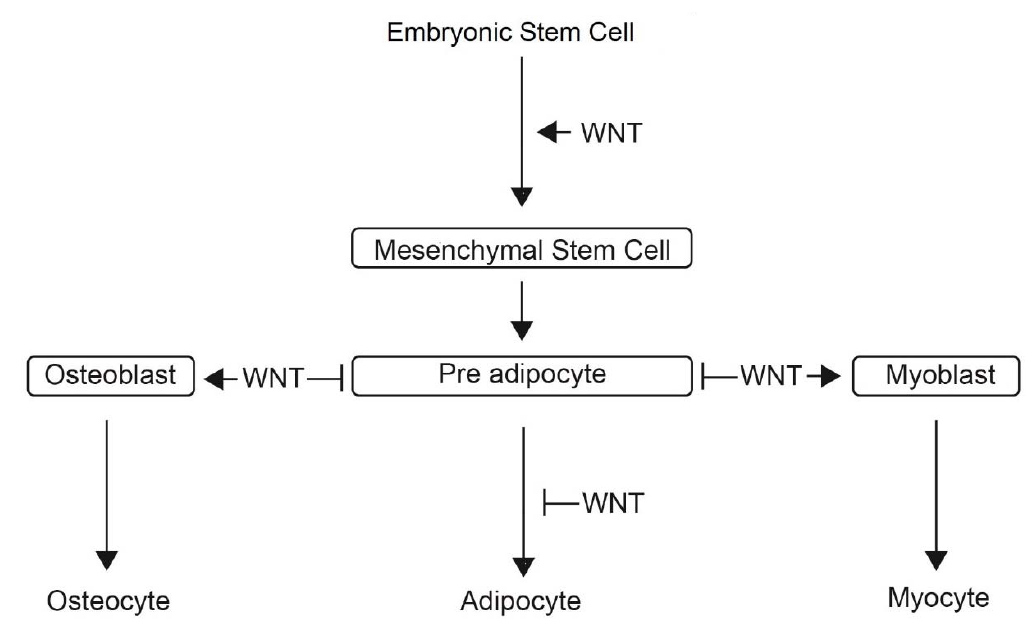
Figure 7. Schematic representation of the role of Wingless/Integrated (Wnt) signalling in embryonic stem cell and pre adipocyte differentiation. Wnt signalling promotes differentiation of embryonic stem cell in mesenchymal stem cell. At the next stage, Wnt antagonists induce differentiation of pre adipocyte into mature adipocytes.